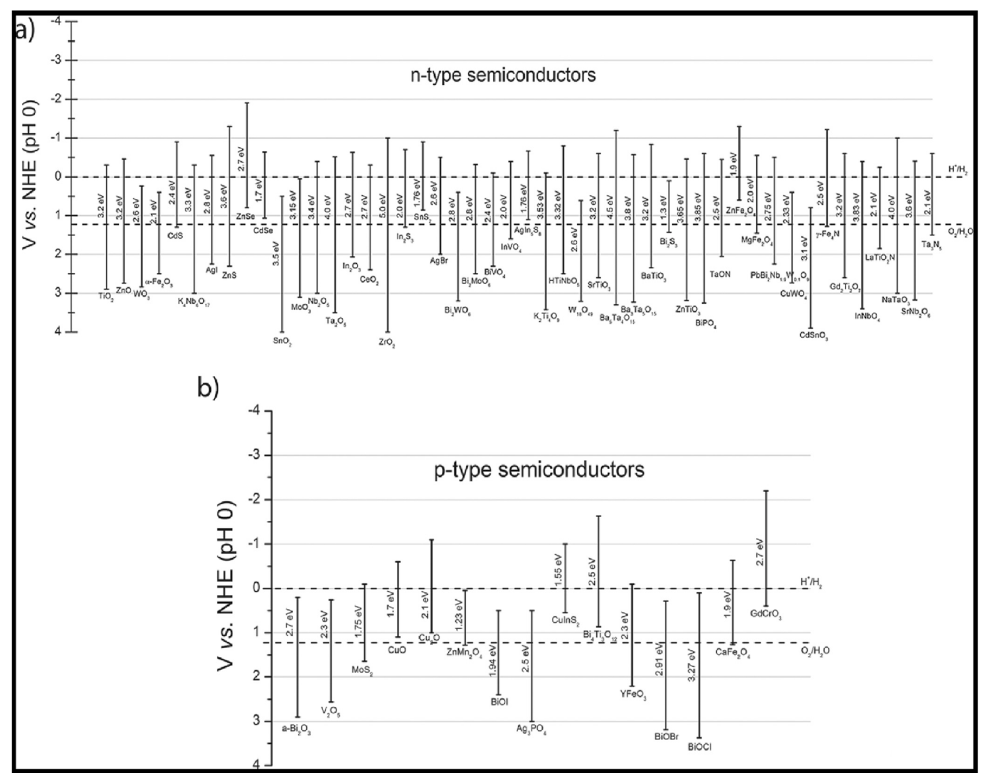
Figure 12. Valence band (VB) and conduction band (CB) band positions of various ( a ) n-type semiconductors; ( b ) p-type semiconductors [111].